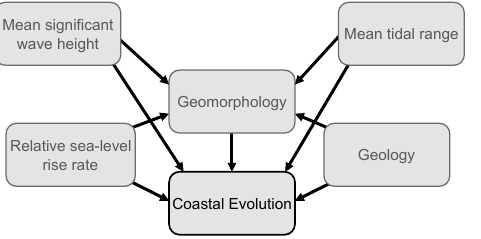
Fig. 1. Bayesian network: the black arrows indicate causal relation- ships linking the forcing factors (gray) and the response variable (coastal evolution, black).